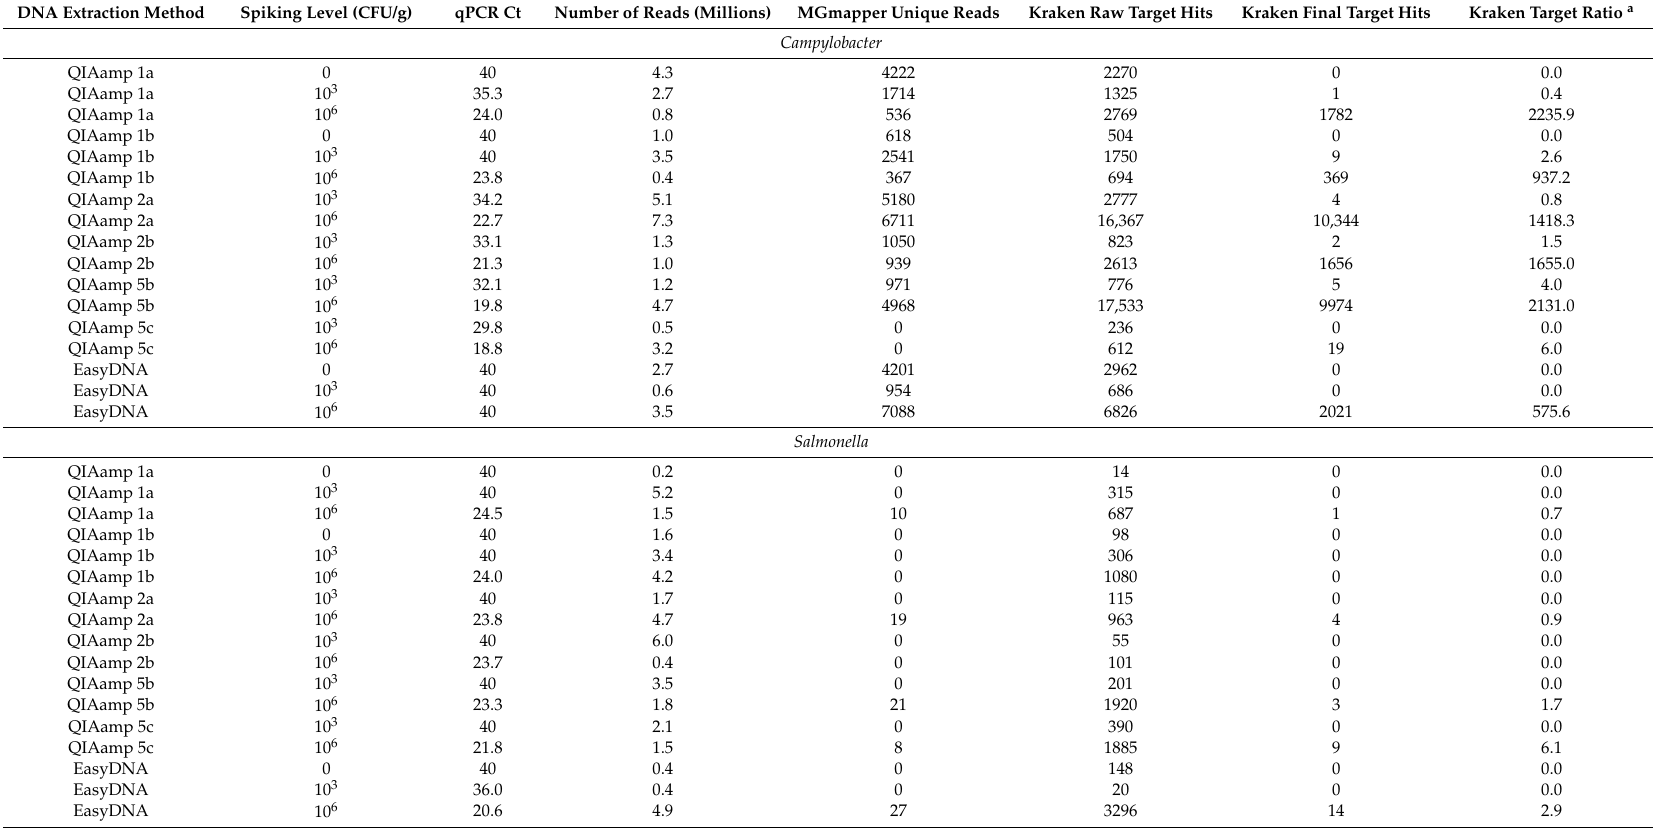
Table 3. Results from qPCR and data analysis on individual